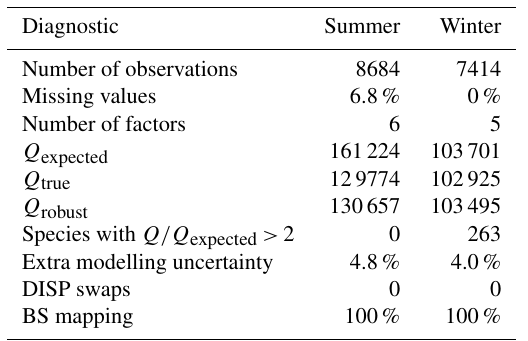
Table A2. Summary of PMF diagnostics for PNSD.